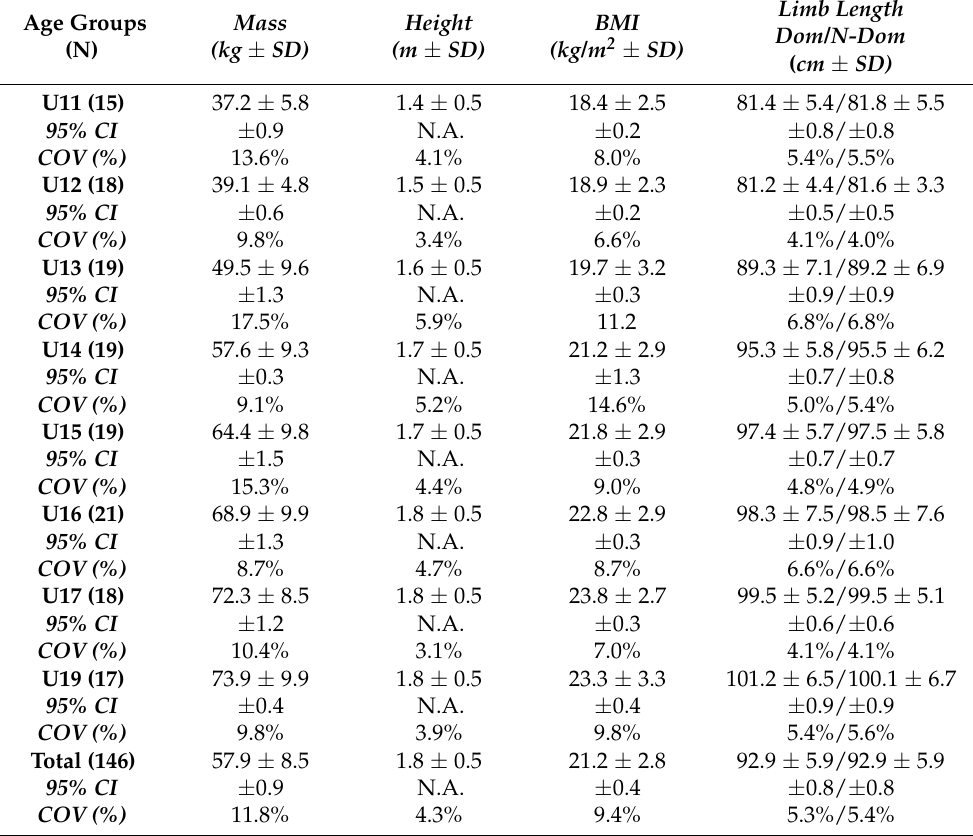
Table 1. Anthropometric data (Mean ±